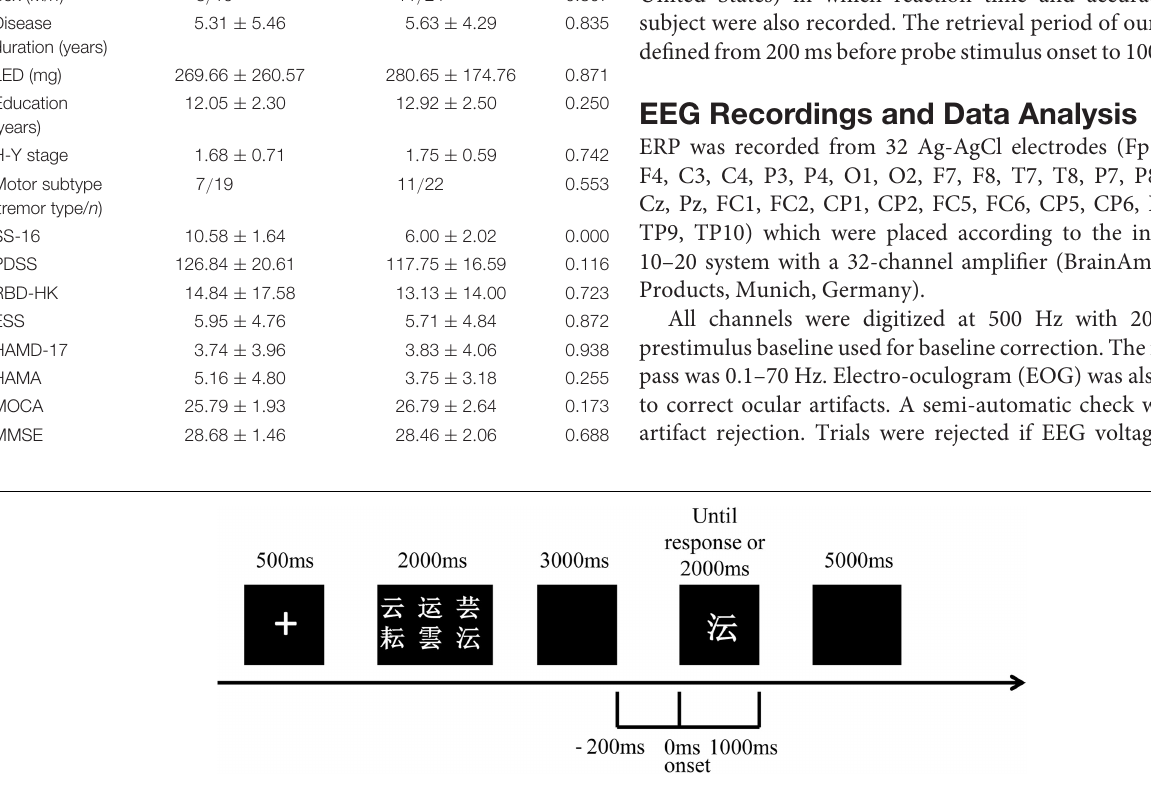
Frontiers in Aging Neuroscience |